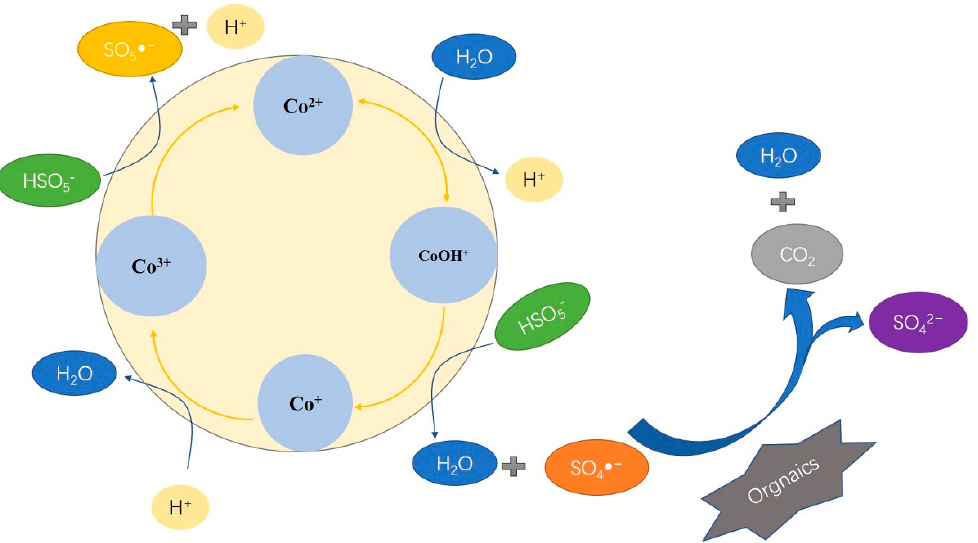
Figure 2. Mechanism diagram of Co catalyst activated PMS for degradation of organic pollutants.